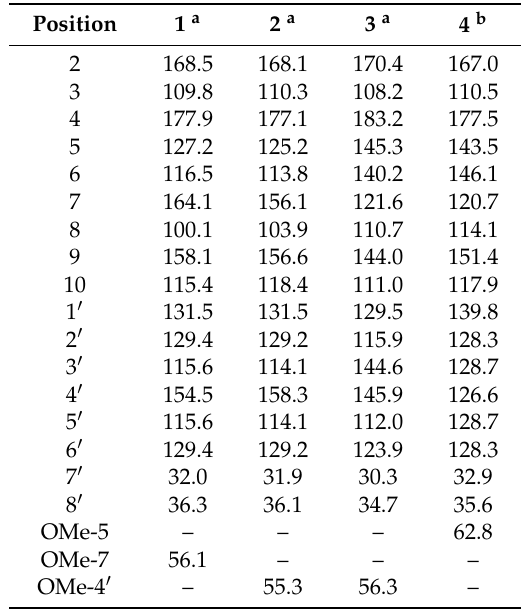
Table 3. 13 C-NMR data for compounds 1 – 4 ( δ in